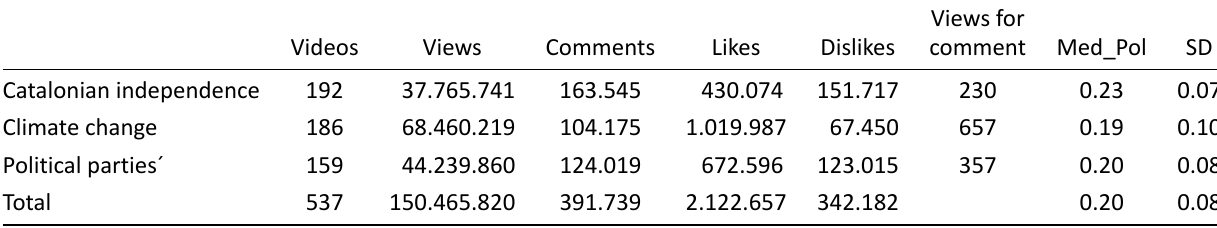
Table 1. Analyzed videos and comments from